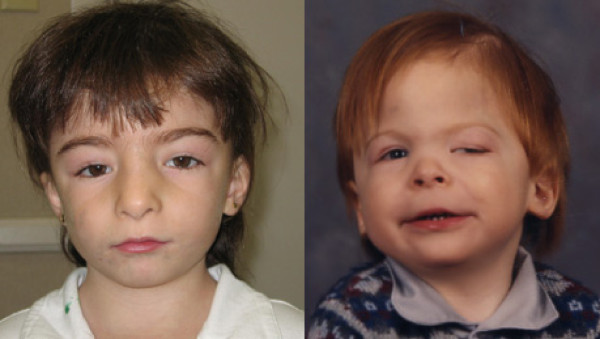
Facial dysmophism in Jacobsen syndrome patients.